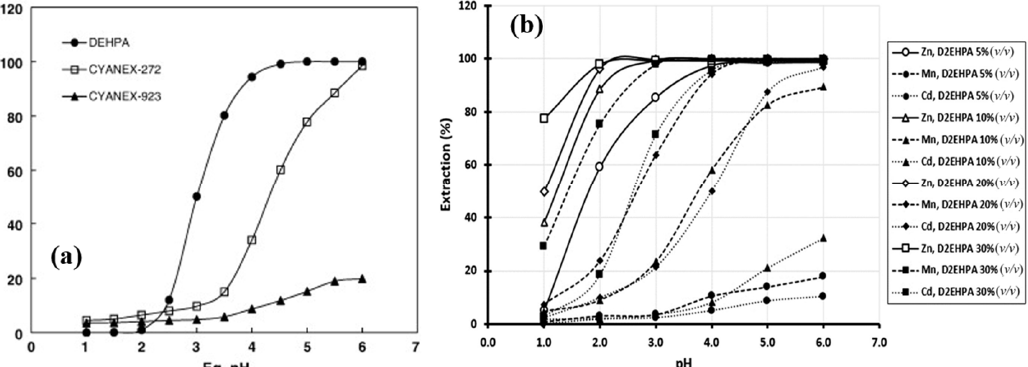
Figure 10. ( a ) Extraction rate of Cd by different extractants, reproduced from [101], with permission from Elsevier, 2009; ( b ) Variation of extraction rate of Zn, Mn, and Cd in chloride solution with different concentrations of D2EHPA at different pH values, reproduced from [99], with permission from Elsevier, 2018.